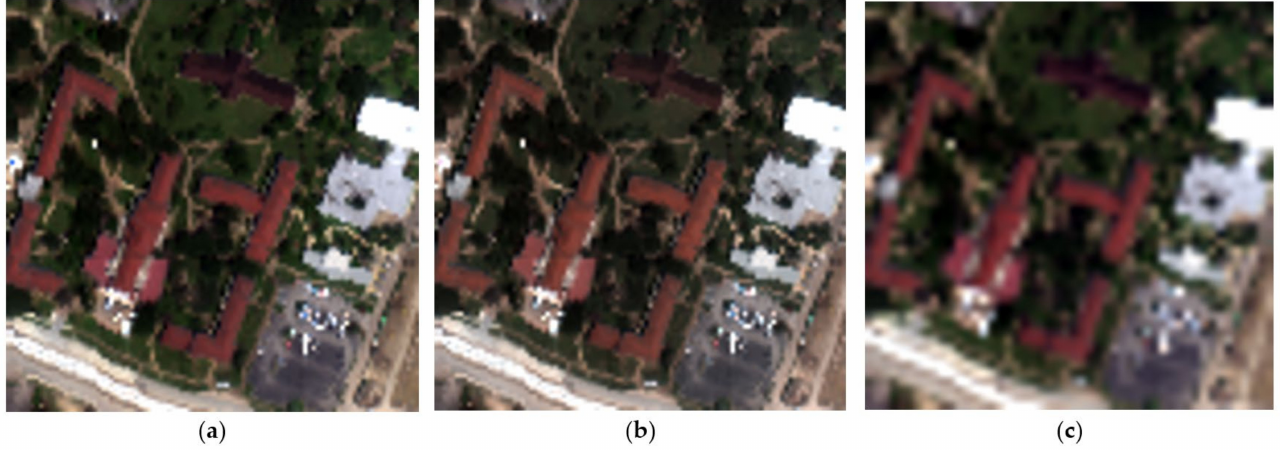
Figure 1. True-color image composite for the synthetic dataset. ( a ) Original Hyperspectral image; ( b ) Low-spectral-resolution multispectral image; ( c ) Low-spatial-resolution hyperspectral image. Table 1. Spectral bands of the QuickBird Sensor [75].